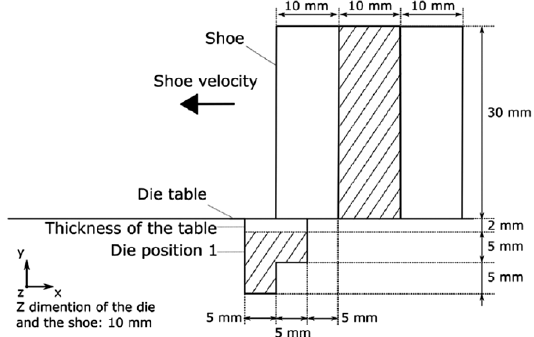
Fig. 2 Schematic diagram of a die-filling system (Yao et al., 2018) Copyright: (2018) Elsevier